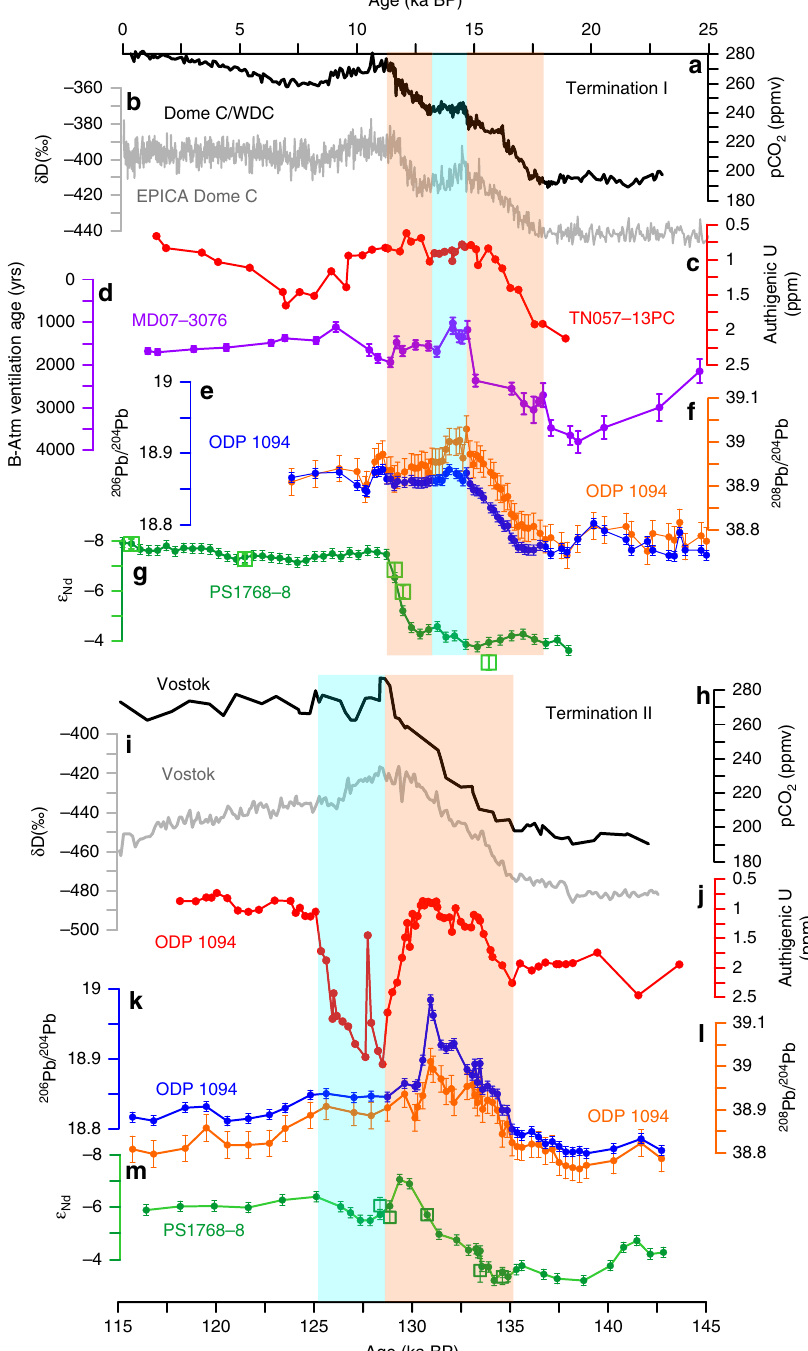
Fig. 5 Reconstructions covering Terminations I and II. a Atmospheric pCO 2 concentrations from Antarctic Dome C ice core 6 and the West Antarctic Ice Sheet Divide ice core (WDC) 11 . b δ D 74 from Dome C and EPICA Dome C ice cores. c Termination I sedimentary authigenic U concentrations at